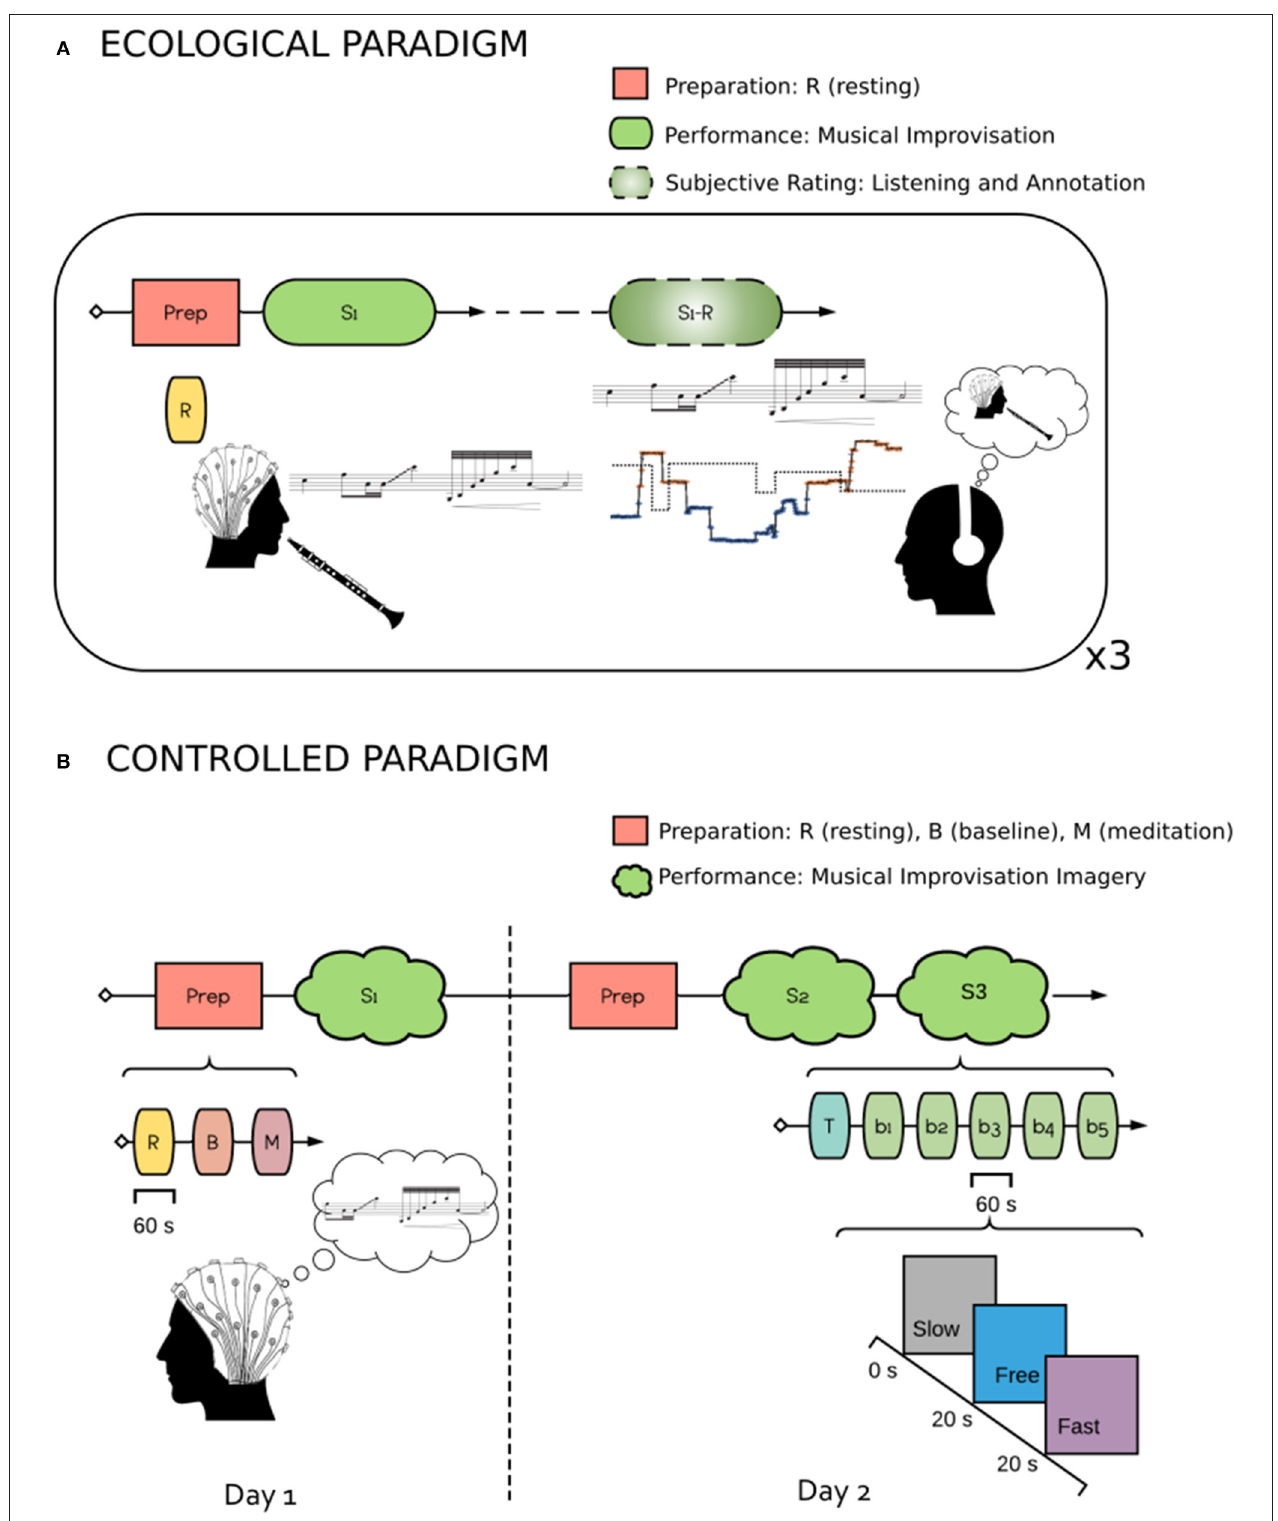
FIGURE 1 | Experimental Protocols Schematics. (A) ecological Paradigm. The experiment included two parts. In the first, EEG was recorded while the subject performed musical improvisation. In the second part, the subject listened to his own performance and performed the retrospective rating using the two factors Focus and STR, detailed in section 2.1.2. (B) controlled Paradigm. The experiment was carried out in 2 days. In the first, the subject underwent a preparation session where he performed 60 s of Resting (Eyes Opened), 60 s of Baseline and 60 s of Meditation. He then performed a musical improvisation imagery task with a Slow, Fast or Free conditions. The second part (2 days later) was as the first, with the exception that two training sessions were performed.